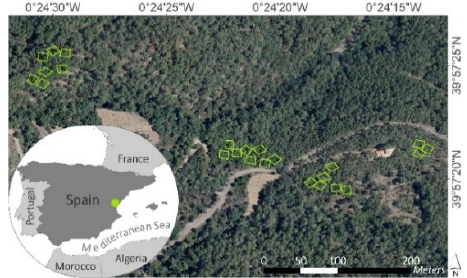
Figure 1. Location of the study area and experimental plots